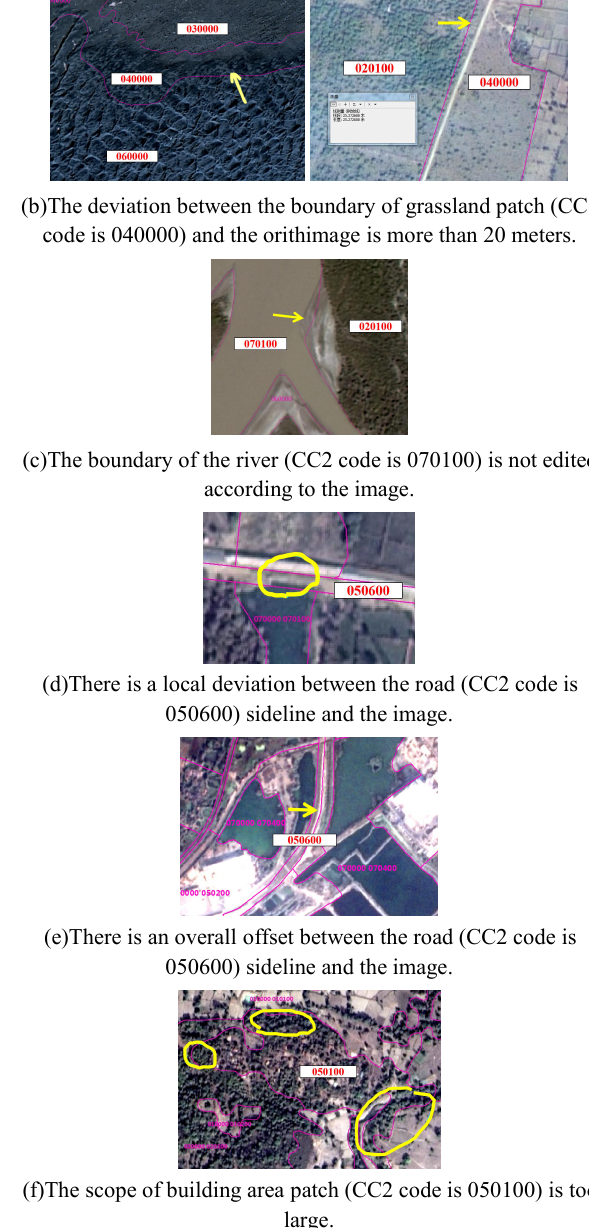
Figure 3 . Acquisition accuracy exceeds the maximum